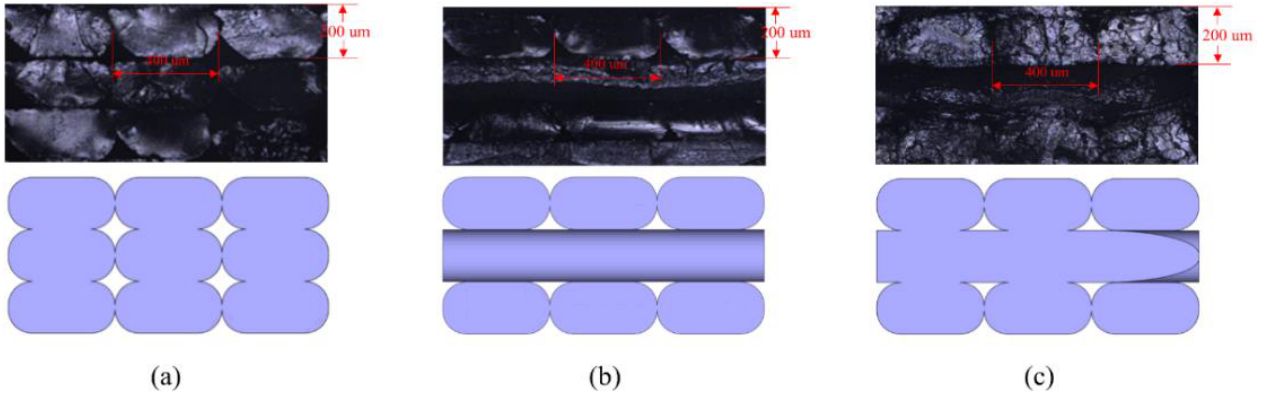
Figure 3. The scanning electron micrographs of the fracture surfaces and the constructed geometric models with three typical cross-infill angles: ( a ) 0 degrees, ( b ) 90 degrees, and ( c ) an in-between cross-infill.